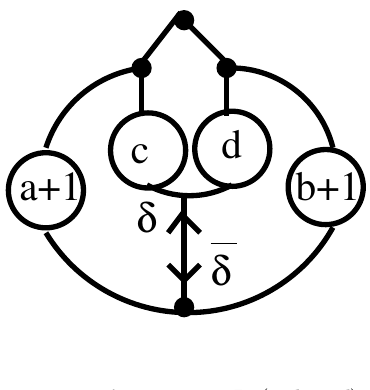
Figure 33 . R 3 ( a; b ; c; d